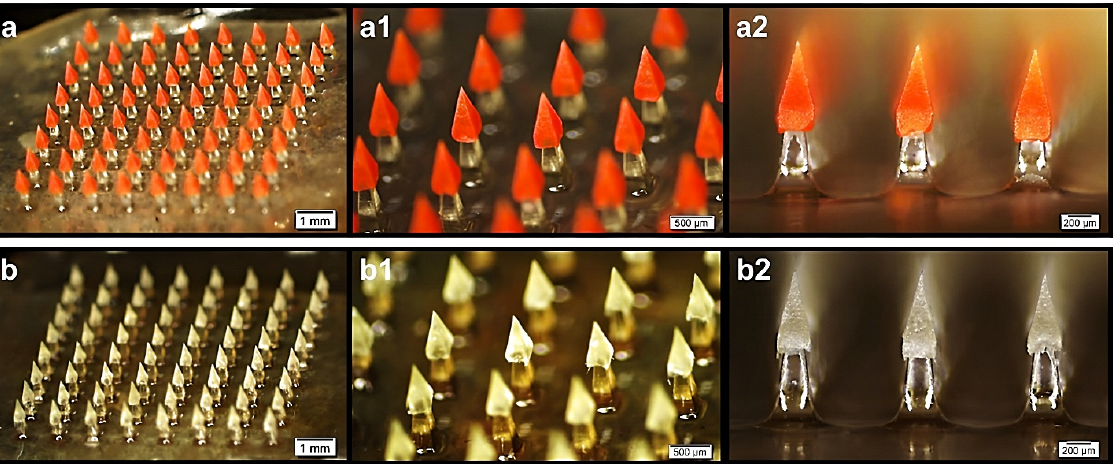
Figure 3. Microscopic images of chitosan-poly(L-lactide-co-D, L-lactide) microneedle array loaded with ( a , a1 , a2 ) rhodamine B dextran and ( b , b1 , b2 ) ovalbumin. Images reprinted with permission from [70].